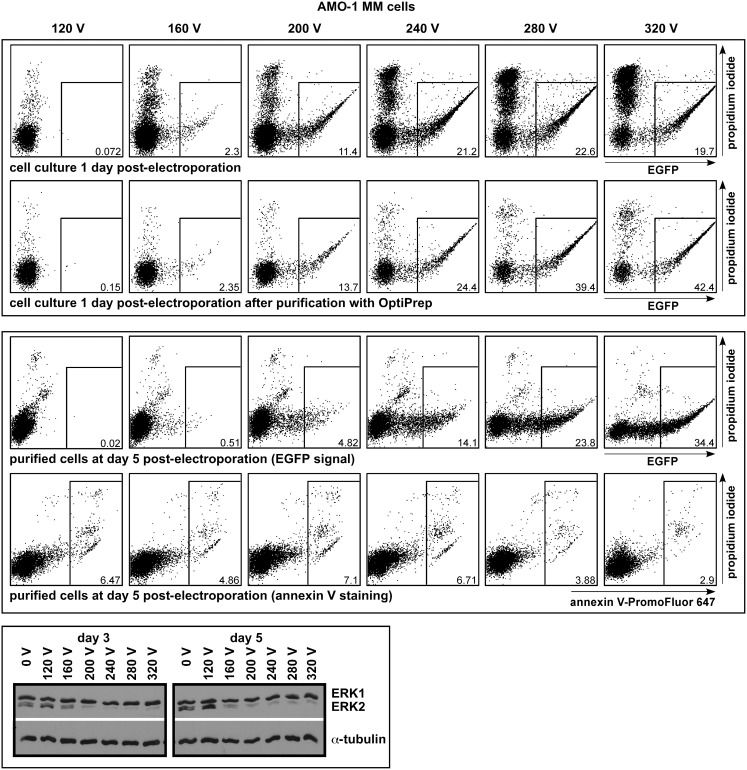
Voltage dependence of electroporation and knockdown efficiency in AMO-1 cells.Transfection of AMO-1 cells across a range of voltages using an expression vector for EGFP (pEGFP-N3) and a stealth siRNA against ERK2 (stERK2) in the electroporation mixture. Top panel: increases of the fractions of EGFP-expressing as well as of dead cells with higher voltages (top row). Cells taken in culture after OptiPrep-mediated debris removal reflect only the increase in transfection efficiency for the EGFP expression plasmid (bottom row). Middle panel: purified AMO-1 cells (those shown in the upper panel, bottom row) after culture for another 4 days. Top row: EGFP expression. Bottom row: annexin V-PromoFluor 647/PI staining. Even for the highest voltage used (320 V) the purified live cell fraction did not fare worse in subsequent culture than cells electroporated under milder conditions. Bottom panel: Western analysis of ERK2 knockdown at days 3 and 5 post-electroporation from the same cultures from which the FACS panels were derived. Efficient siRNA-mediated ERK2 knockdown was achieved at voltages significantly lower than required for the best levels of plasmid electroporation. However, a lower limit for successful knockdown was reached between the settings for 160 and 200 V. Shown is a representative experiment of two complete sets (Western blotting included). Anti-ERK1/2 antibody: CST.